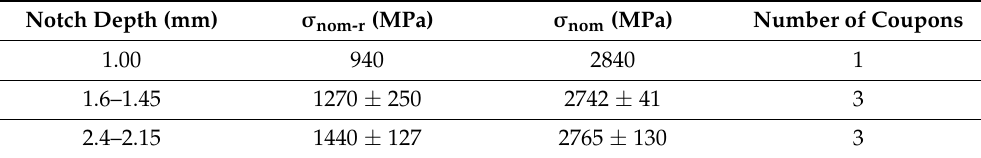
Table 6. Mechanical properties of holed coupons in the compression mode of loading.